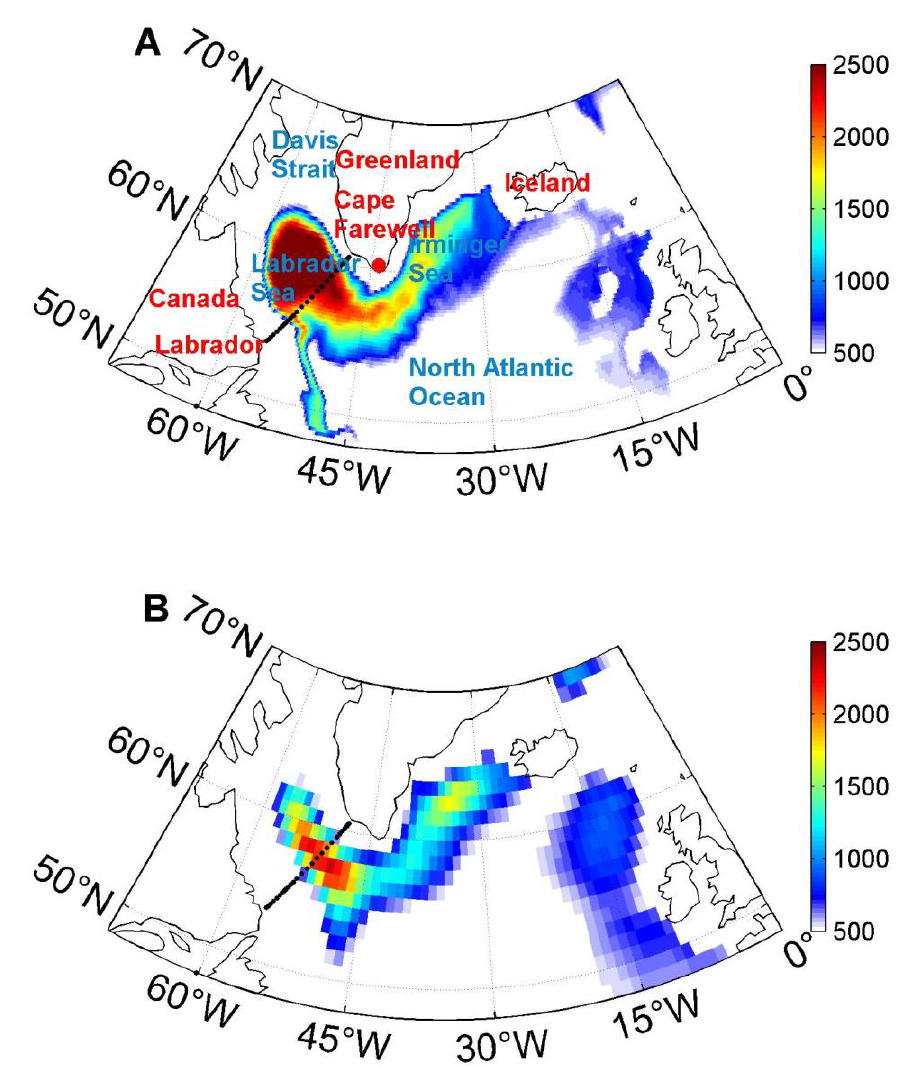
Figure 1. The spatial distributions of March-mean MLD (m) in ECCO2 ( A ) and EN4 ( B ) averaged over 1979–2017. The AR7W section is labelled by the black dotted line. The geographical and sea names are also labeled in ( A ).